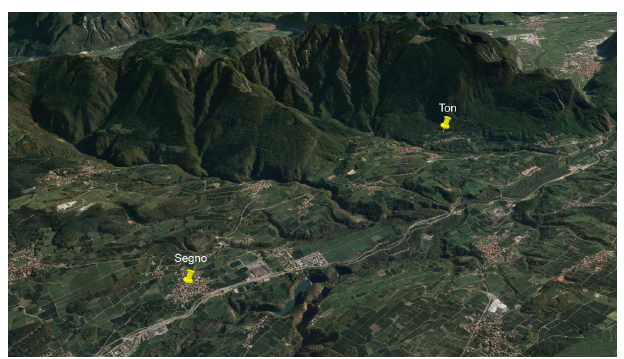
Figure 11. Segno and Ton geographical position view, geodesic distance of about 3.35 km.